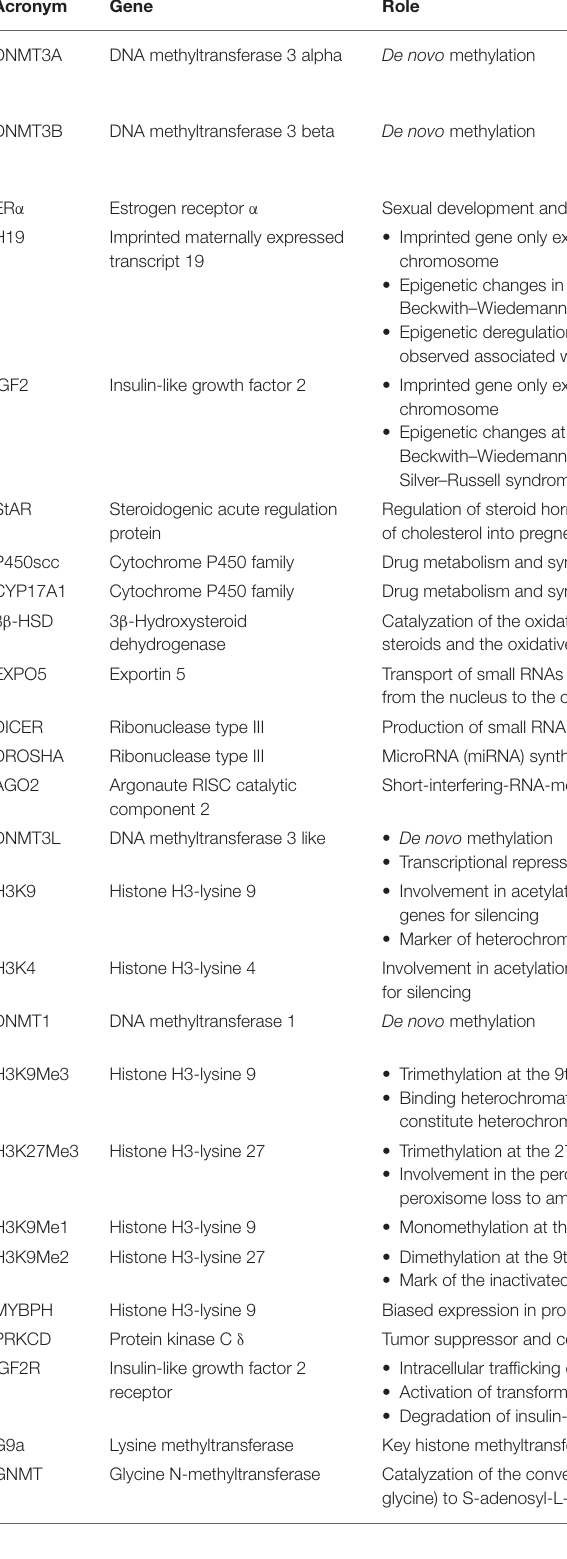
TABLE 1 | Genes studied in relation to BPA exposure and male reproductive system